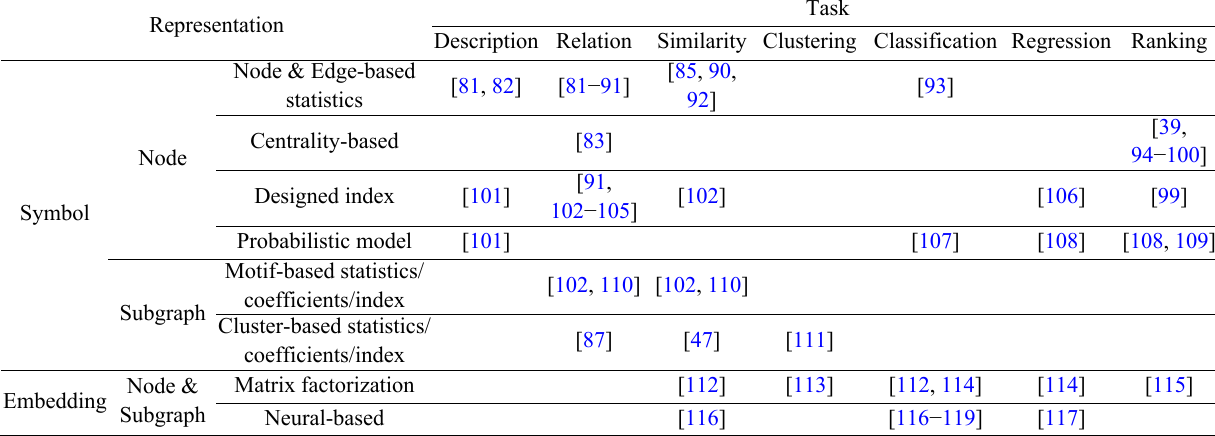
Table 3 Applications of symbol-based and embedding-based network representations. Representation